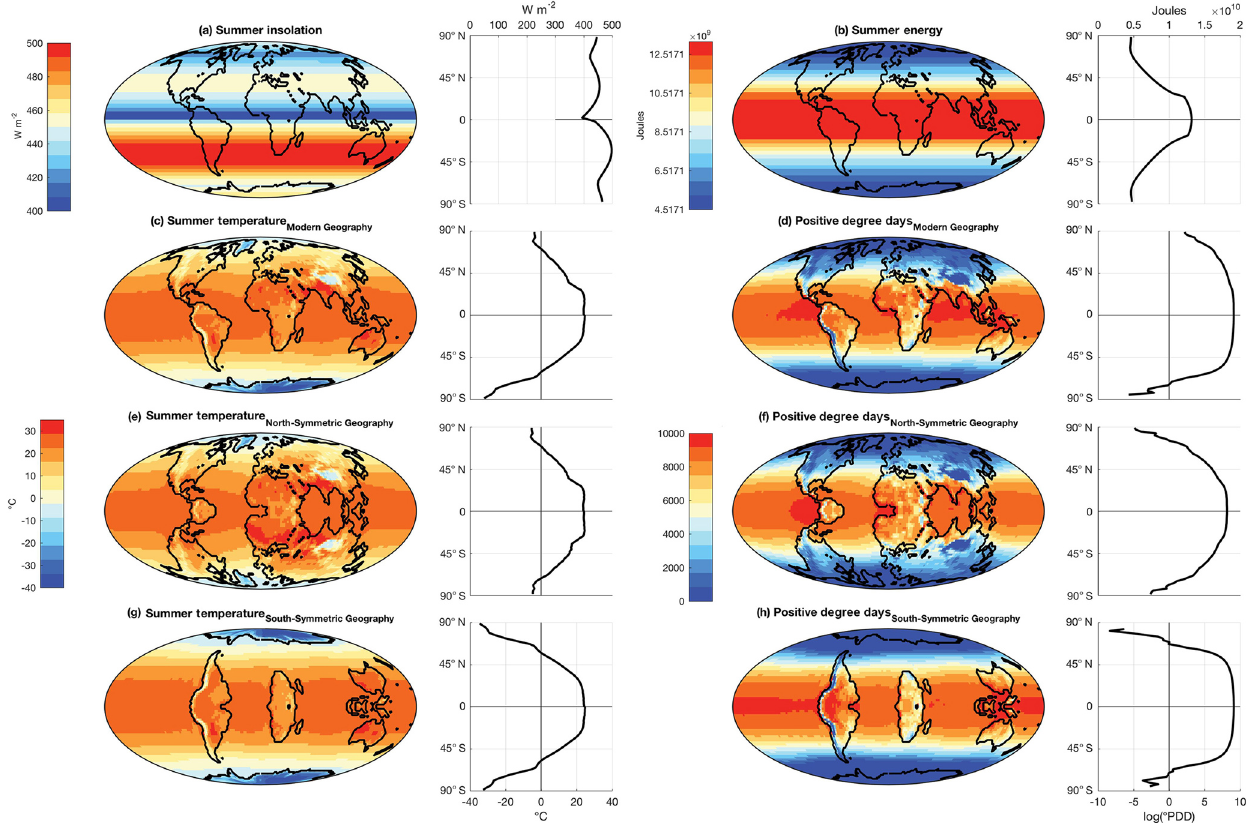
Figure 3. (a–d) Demonstration of Earth’s asymmetric climate response to symmetric climate forcing. Simulations are forced with modern orbit: (a) summer insolation; (b) summer energy (as defined in Huybers, 2006); (c) summer temperature; and (d) PDD. (e–h) Demonstration of Earth’s symmetric climate response to climate forcing when idealized symmetric Earth geographies are used. Simulations are forced by modern-day orbit: (e, f) summer temperature and PDD for NORTH-SYMM simulation, (g, h) summer temperature and PDD for SOUTH- SYMM simulation. The zonal averages are plotted on the right of each panel. Zonal averages of PDD are plotted on a log